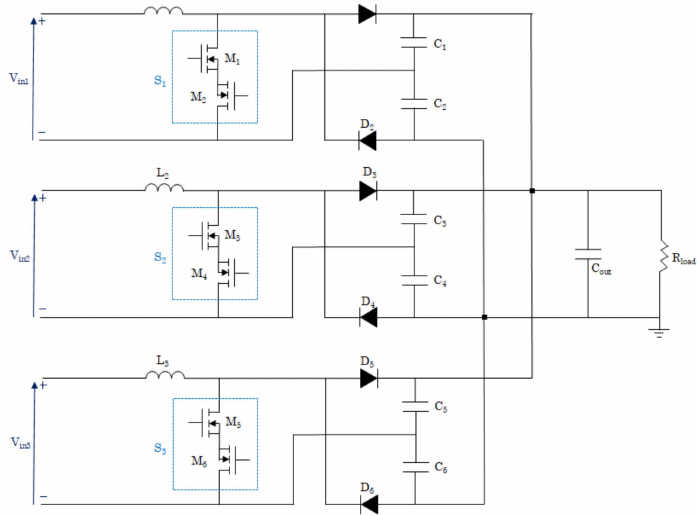
Figure 25. Split N capacitor three-phase